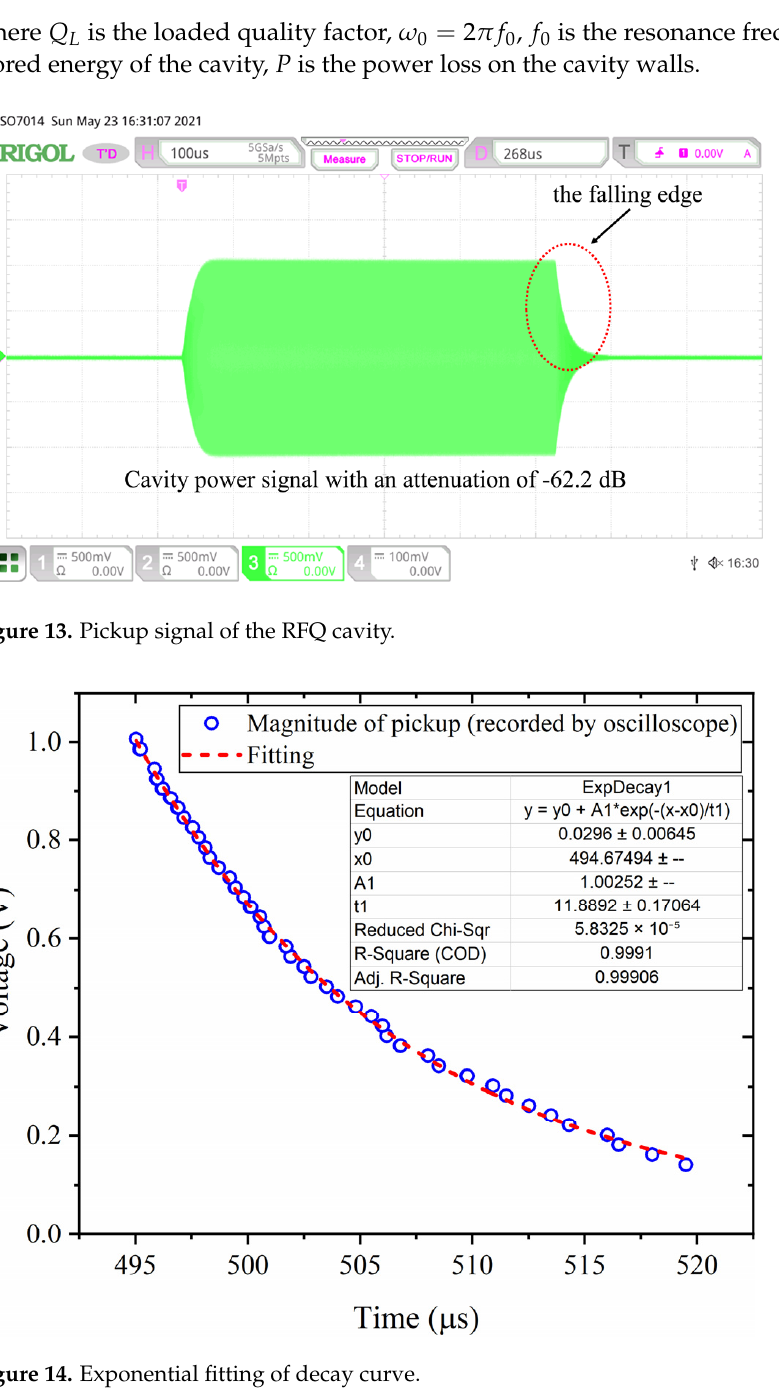
Figure 12. Square of inter-vane voltage as a function of cavity power.